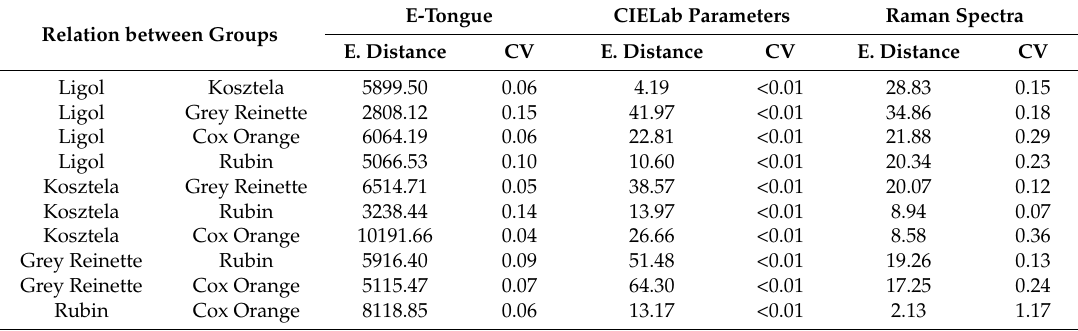
Table 3. Calculated values of Euclidean distances and coefficients of variation between groups according to PCA results from e-tongue, CIELab parameters and Raman